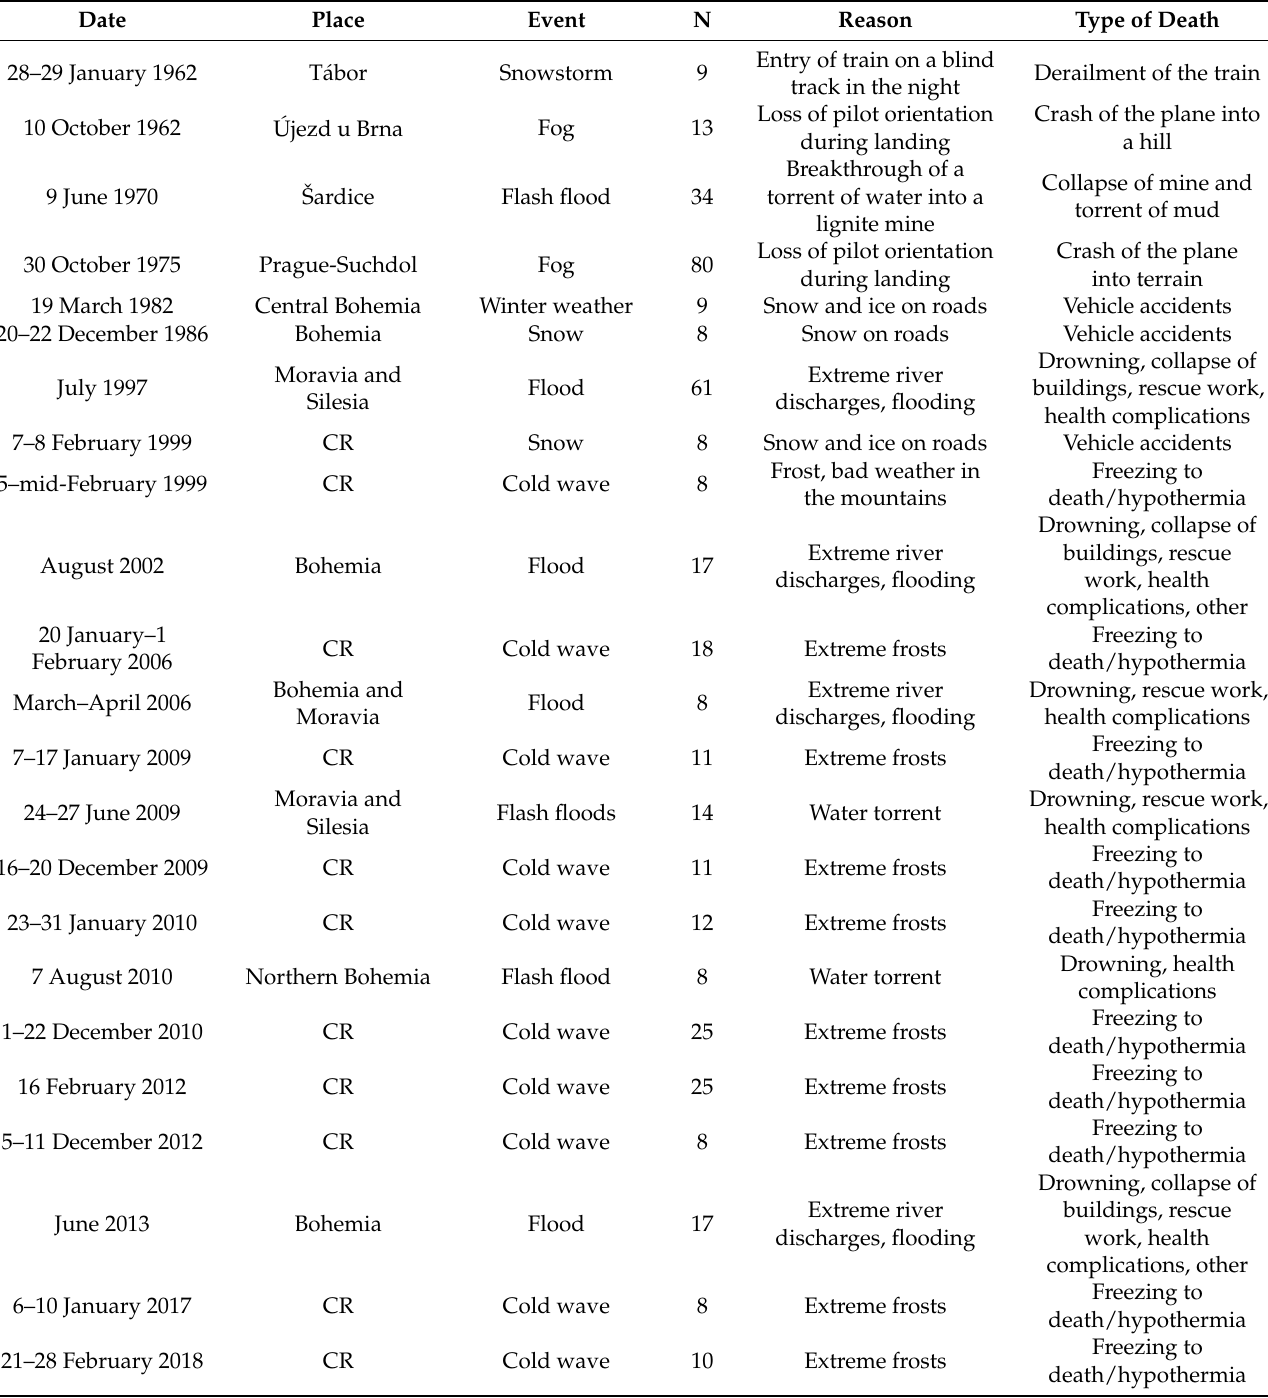
Table A1. Deadly events (with at least eight fatalities) associated with weather in the Czech Republic during the 1961–2020 period (N—number of